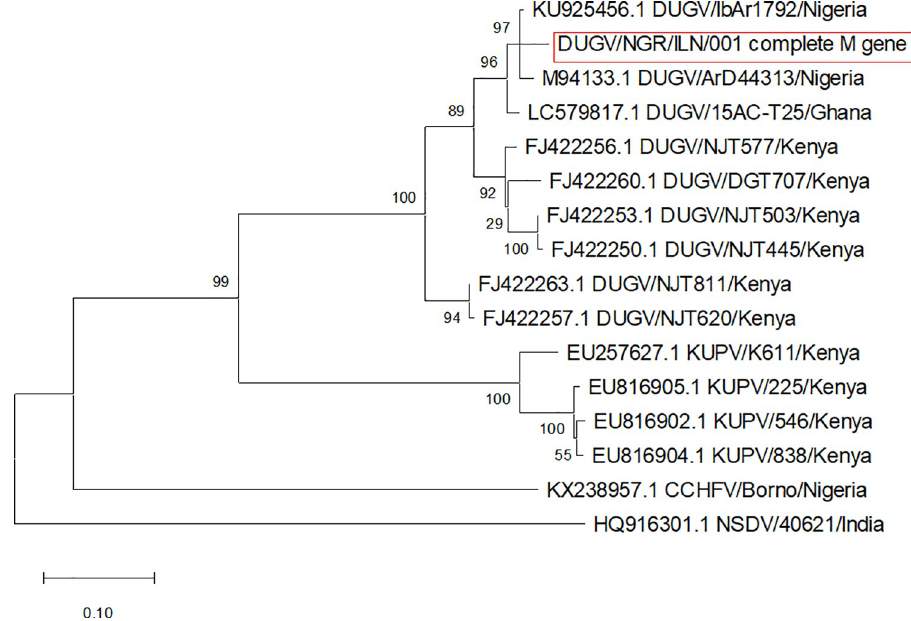
Fig 4. Phylogenetic relationship among DUGV strain recovered in this study and reference strains based on nucleotide sequence of a 4,900 bp fragment of the M segment